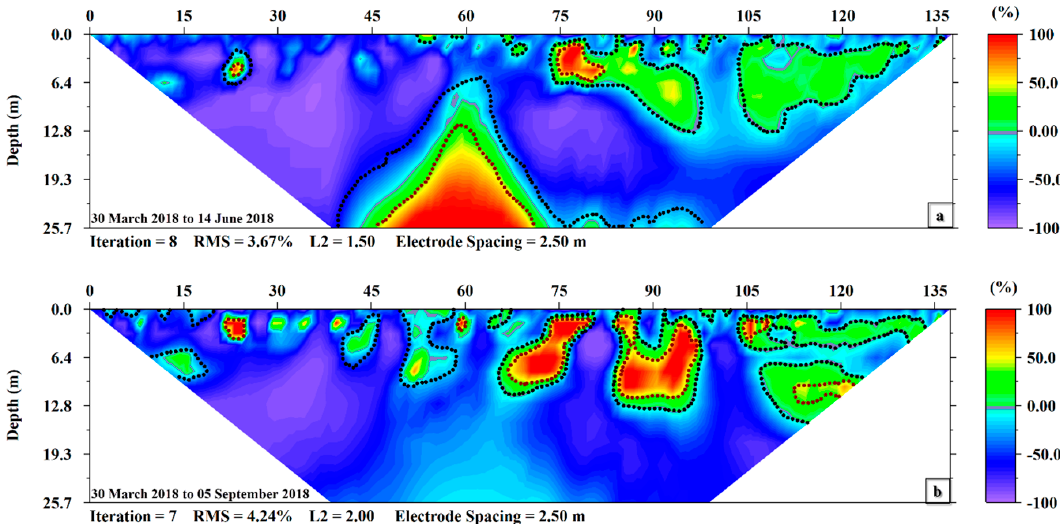
Figure 10. Time-lapse inversion of line one with root mean squared (RMS) error: ( a ) 30 March 2018 to